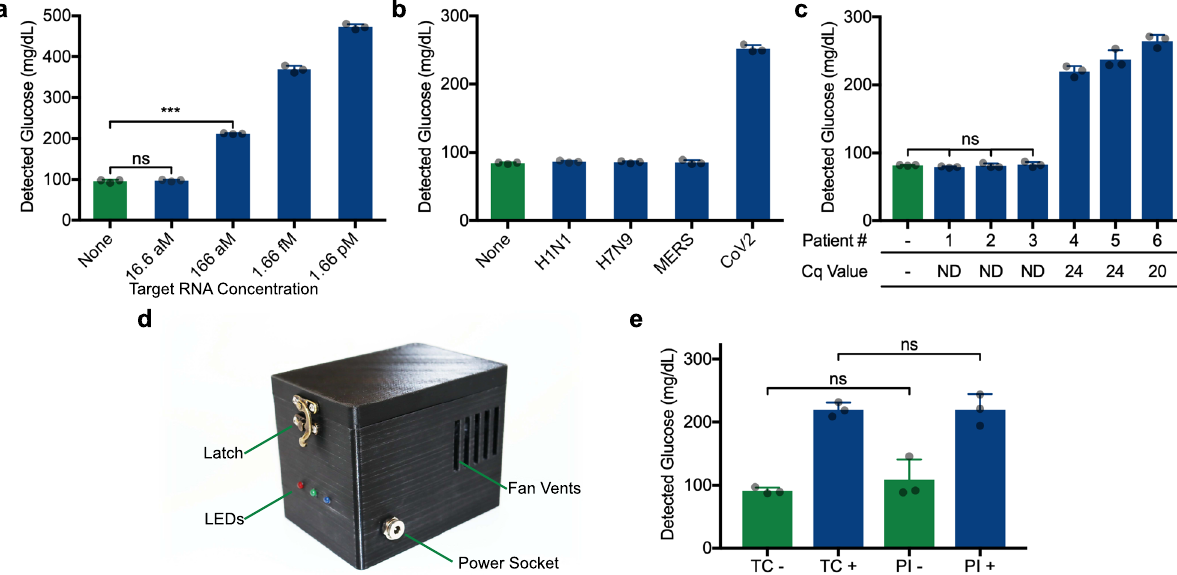
Fig. 5 Demonstration of the SARS-CoV-2 gene N sensor coupled to glucose meter detection. a Assay sensitivity (using N3 B toehold switch) demonstrated with puri fi ed viral RNA. The concentration indicated re fl ects the viral RNA concentration of the 1 µ L aliquot added to NASBA reactions prior to glucose generation. *** p = 0.0001. b The SARS-CoV-2 gene N sensor (N3 B) speci fi city was tested using viral RNA genomes isolated from in fl uenza A subtypes H1N1 and H7N9, MERS and SARS-CoV-2 using an initial RNA concentration of 1.66 pM. c Sensor N3 B performance upon exposure to RNA extracted from 6 different patient samples (3 SARS-CoV-2 positive and 3 negative patients) assayed with glucose-based sensor. Switch DNA template present at 1.25 ng/ µ L. Neg: no RNA sample added to NASBA. Cq values from the parallel RT-qPCR assay of these sample listed on the x-axis. ND: not detected. d Companion portable incubator. This device is capable of facilitating the experiment in place of a thermocycler. e Using sensor N3 B, direct comparison between the thermocycler (TC) and portable incubator (PI). SARS-CoV-2 RNA was added to positive ( + ) reactions at 1.66 pM. For c , statistical analysis is one-way ANOVA. a and b are comprised of 3 technical replicates, representative of 3 independent experiments. e is comprised of 3 biological replicates. ns: not signi fi cantly different. Data are presented as mean values ± SD. Source data are provided as a Source Data fi